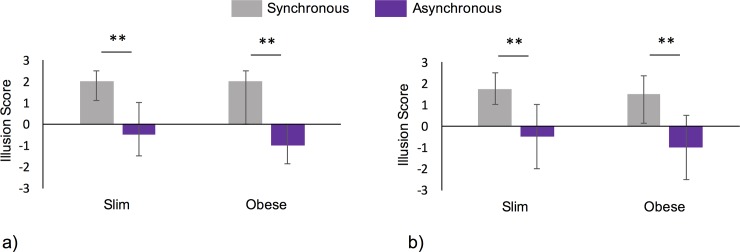
Illusion scores for experiments one and two.Agreement with illusion relevant questionnaire items was higher following synchronous touch (light grey bars) than following asynchronous touch (mauve bars) for both the slim and obese bodies in experiment one (a) and experiment two (b). No significant difference in illusion strength was identified between the two body sizes for either experiment. Bars represent median scores and error bars depict inter-quartile ranges. ** = p < .001.